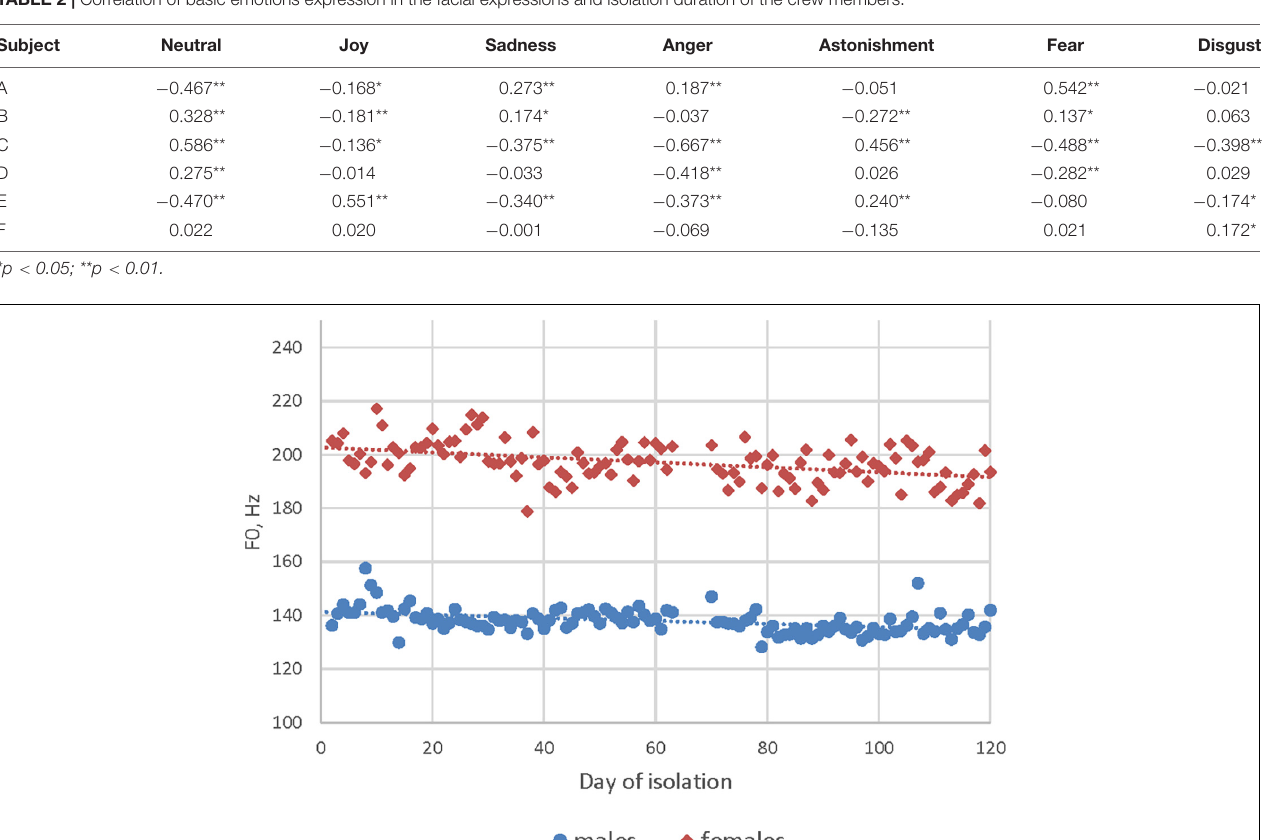
TABLE 2 | Correlation of basic emotions expression in the facial expressions and isolation duration of the crew members.